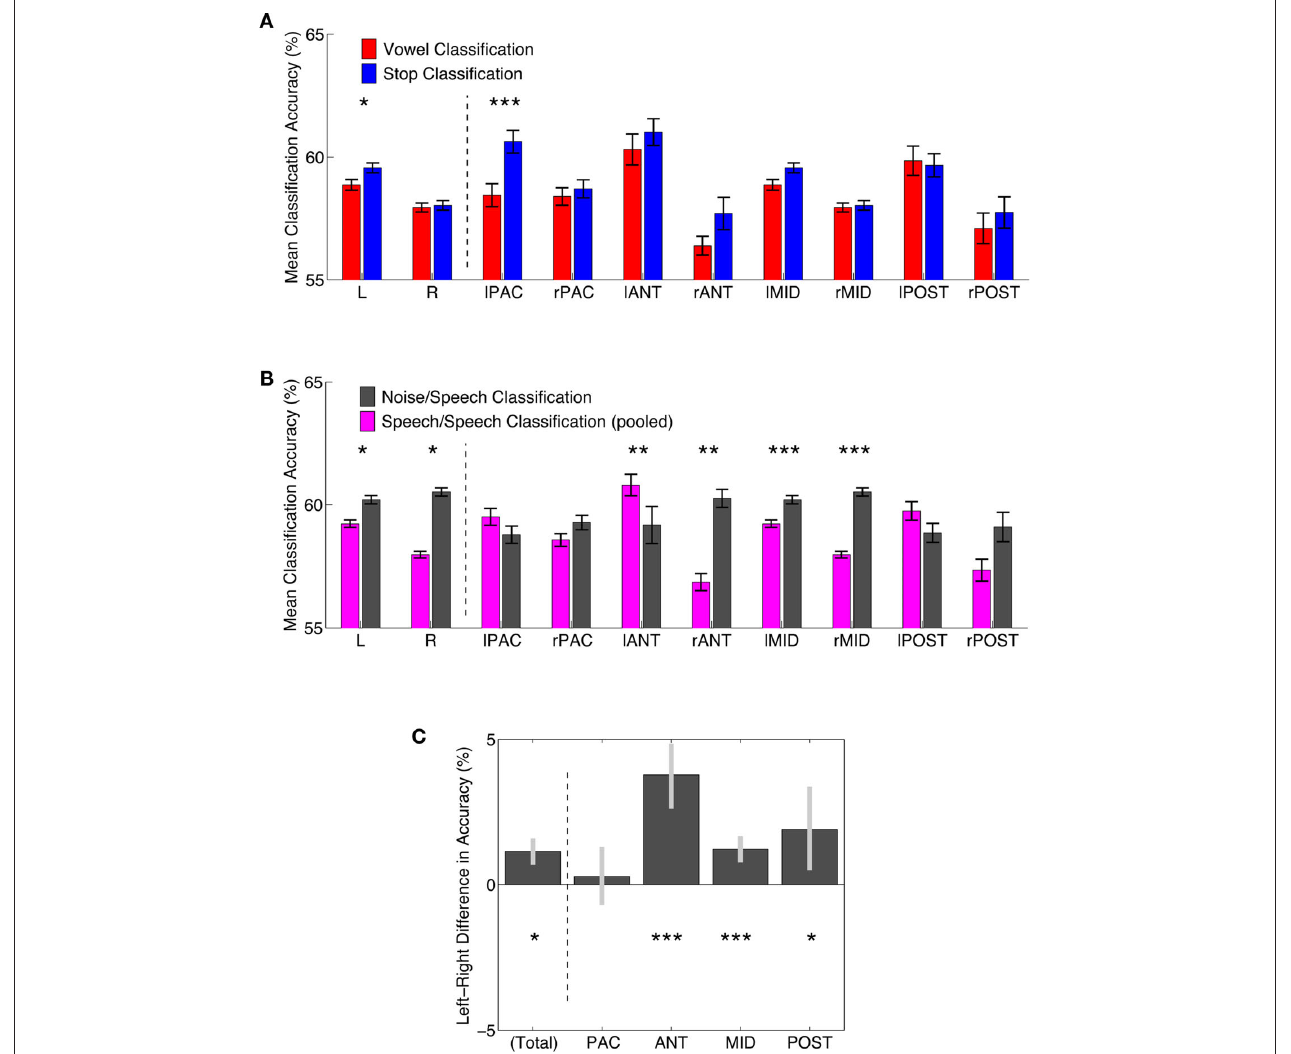
(purple). Means of all FCR-corrected above-chance voxels within a region ±1 standard error of the mean are shown. Asterisks indicate a FDR-corrected significant difference; * p < 0.05, ** p < 0.01, *** p < 0.001. (C) Left–Right hemisphere differences for speech–speech classification (accuracies averaged across vowel and stop). Mean differences in accuracy ± 95% confidence limits are shown. Asterisks indicate a FDR-corrected significant difference; * p < 0.05, ** p < 0.01, *** p < 0.001. NB, the anterior regions show the most distinct left-bias for mean classification accuracy, while the primary areas show no significant